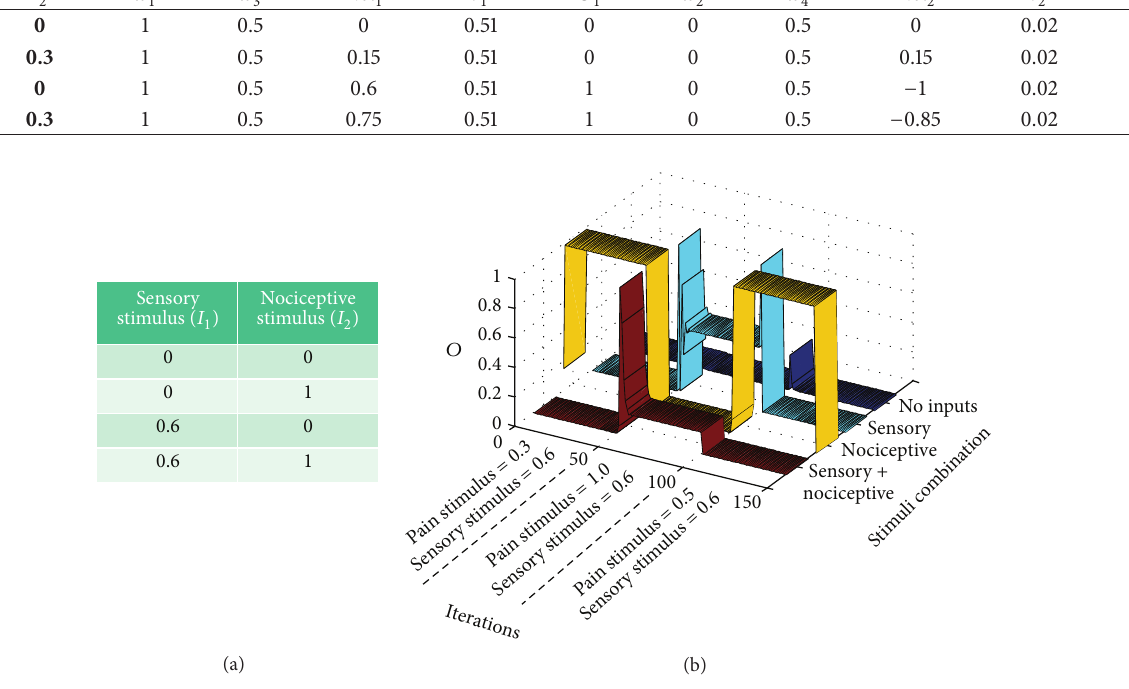
Figure 9: Modeling breakthrough pain: after 50 iterations with standard training epochs, an intense nociceptive stimulus is input to the gate. Initially, wind-down pain (yellow ribbon) takes place concomitantly with a mild episode of dysesthesia (cyan ribbon). After a period in which pain seems to be relieved, pain is again installed as in breakthrough